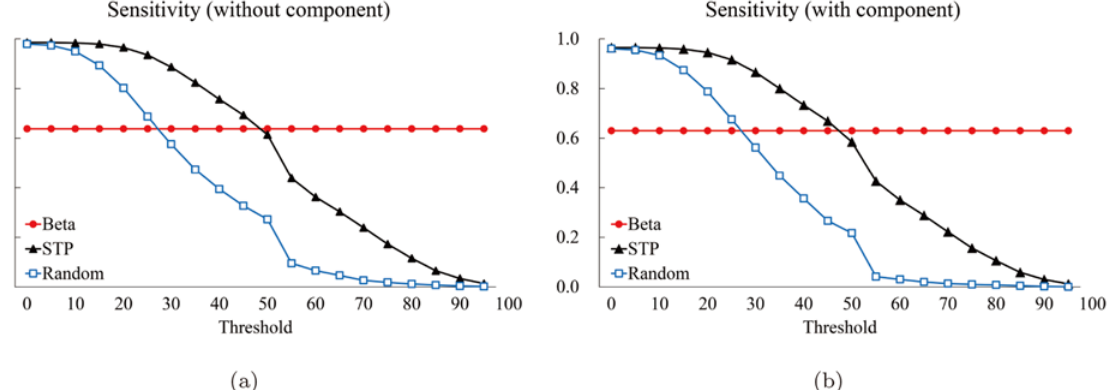
Fig 21. The sensitivity graphs. The red circle corresponds to the proposed method. The black triangle and blue square correspond to the average value (of the 85 structures of the Astex Diverse Set) for the STP and Random methods for each threshold value, respectively. The horizontal and the vertical axes denote the thresholds and the computed values of sensitivity, respectively. (a) Sensitivity for “ Without (component) ” and (b) one for “ With (component). ”